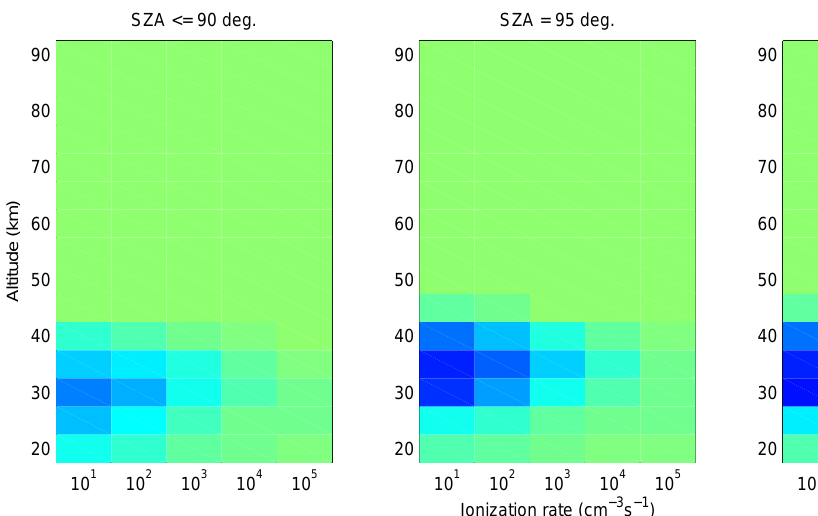
/Q for January 2 O 5